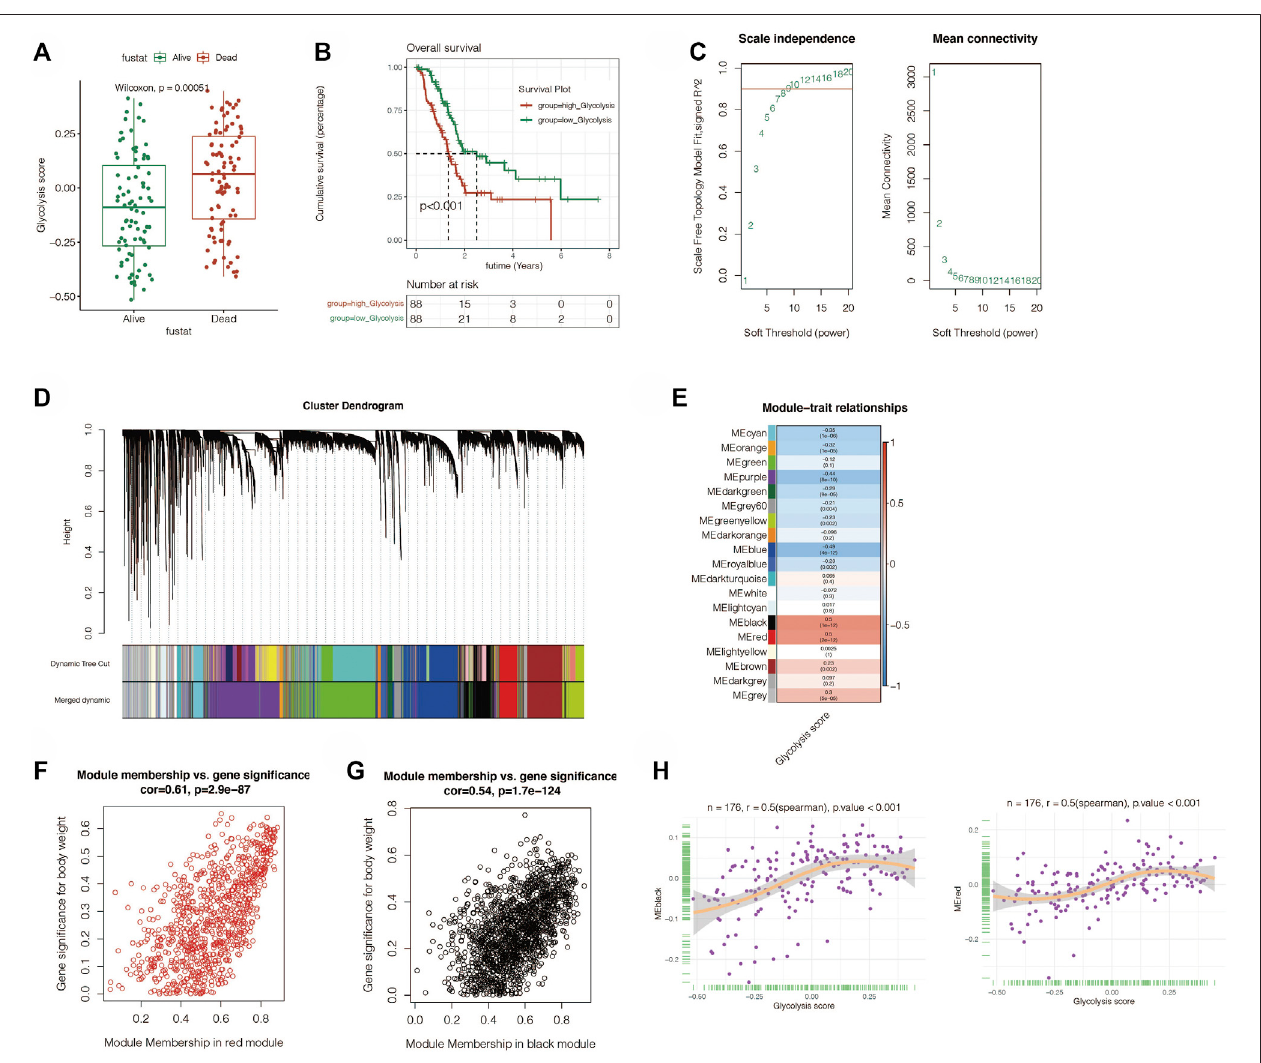
FIGURE 2 | ssGSEA analysis and weighted gene correlation network analysis (WGCNA). (A) ssGSEA analysis showed that the glycolysis score was obvious elevated in the dead PC patients. (B) Survival analysis revealed that the high-glycolysis group has a worse prognosis. (C) Best soft threshold of WGCNA was 7. (D) WGCNAanalysisfound18no-graygenemodules. (E) Correlationbetweenthemodulesandglycolysis.Theblackandredmoduleshadthestrongestcorrelationwiththe glycolytic phenotype (Cor = 0.5 and p < 0.001). (F,G) Relation between module membership and gene signi fi cance in red and black modules. (H) Correlation between red and black modules and